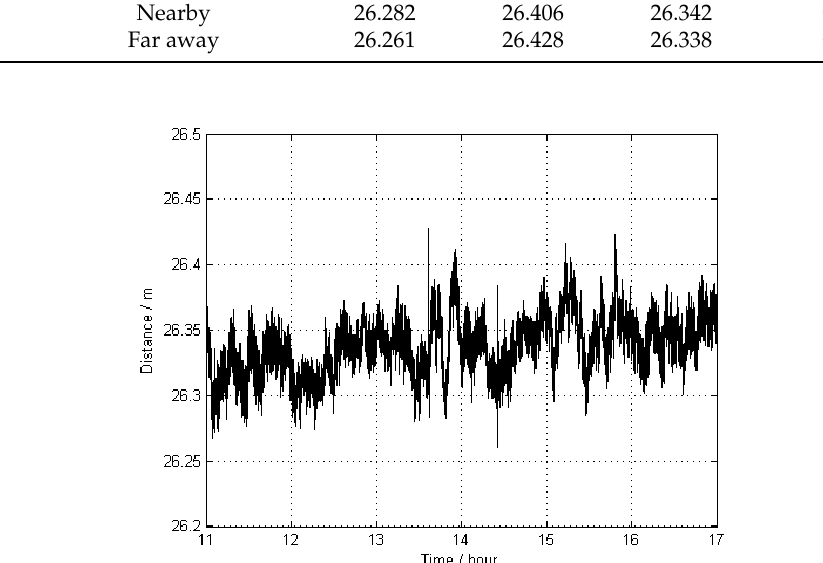
Figure 5. Apparent distance (as a function of time) between the two antennas KIN1 and KIN3 without distance constraints; the trajectories of these antennas were estimated by using two far-away-located reference stations, WARN and POTS (Scheme 2). Table 2. The statistical results for the distance between KIN1 and KIN3 (Unit: m).